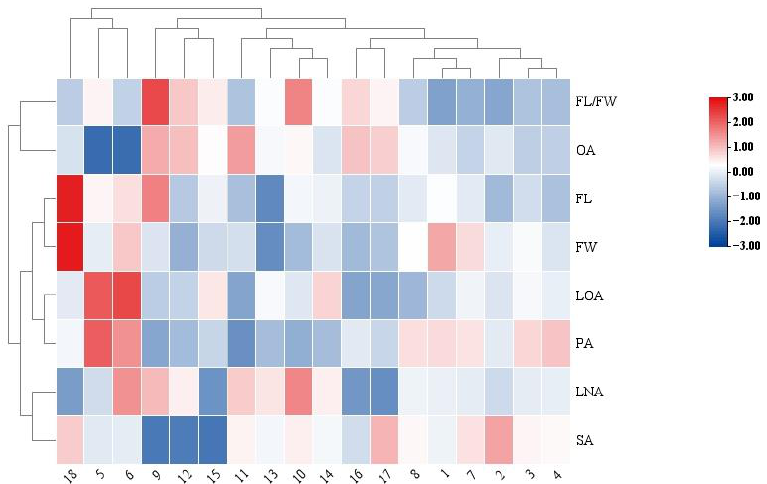
Figure 2. Heatmap of fruit morphology and fatty acid composition in Camellia oleifera . Fruit morphology and fatty acid data were scaled by subtracting the values from the mean. Thus, positive values (red) indicate above the mean, and negative values (blue) indicate below the mean. FL, fruit length; FW, fruit width; OA, oleic acid; LOA, linoleic acid; LNA, linolenic acid; PA, palmitic acid; SA, stearic acid. Different numbers represent different sites shown in Table 1.